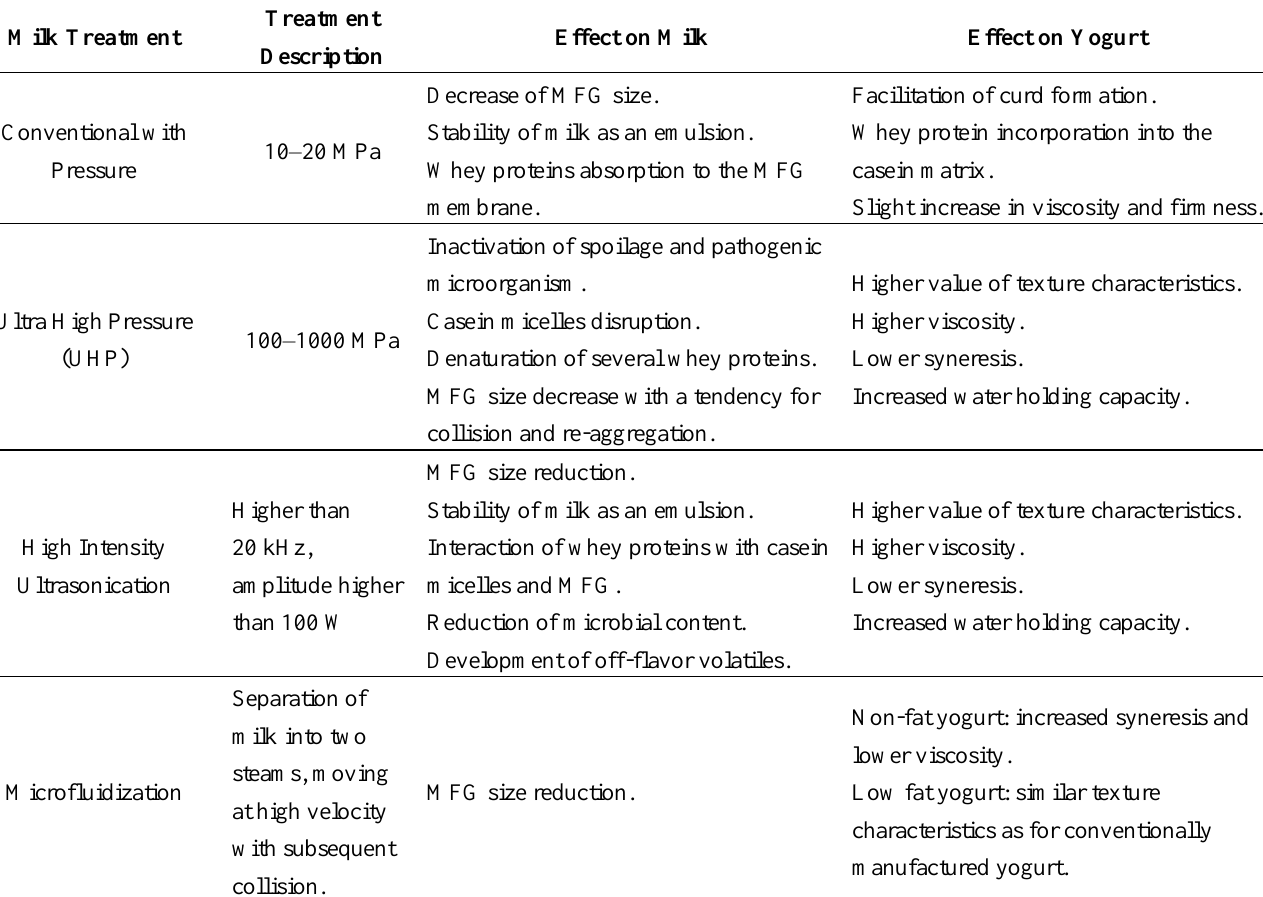
Table 2. Impact of different homogenization techniques on milk and yogurt properties affecting flavor and